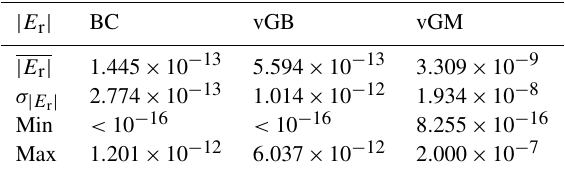
Table 1. Absolute values of relative errors, | E r | , between the pro- posed mixed formulation, S ∗ , and the targeted scaled sorptiv- M √ c p , with the mean | E r | , the standard deviation ity, S ∗ ( −∞ , 0 ) = ( σ | E ), the minimum and the maximum values for the three hy- r | draulic models whose sorptivity is analytically tractable: Brooks and Corey (BC), van Genuchten–Burdine (vGB), van Genuchten– Mualem (vGM). Note that 10 − 16 corresponds to the relative preci- sion of numbers in Scilab. | E r